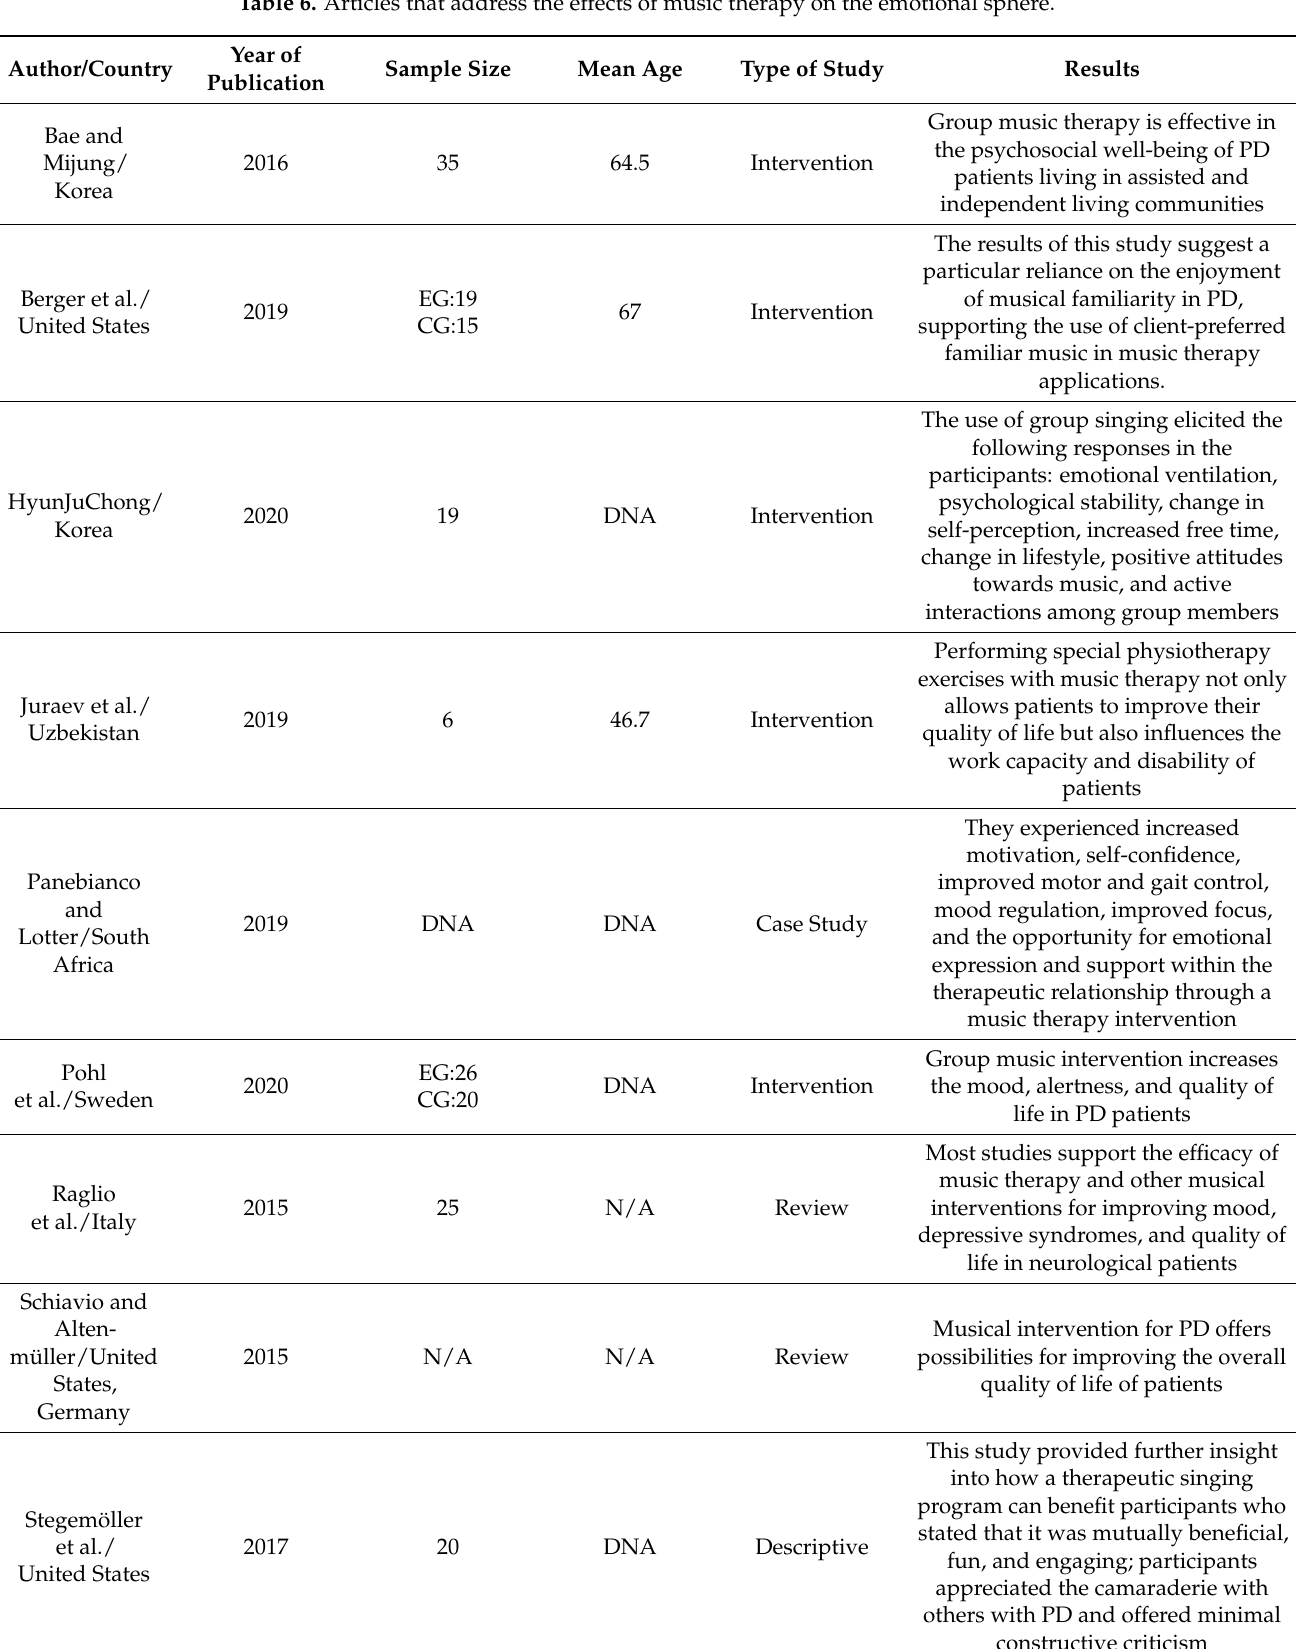
Table 6. Articles that address the effects of music therapy on the emotional